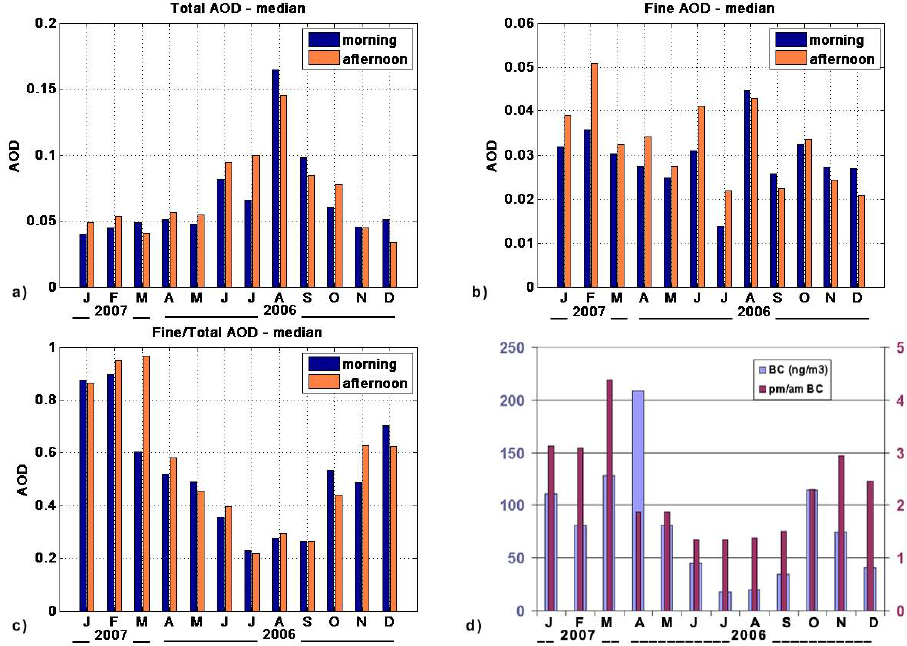
Fig. 5. Ev-K2-CNR monthly medians of morning (blue bars) and afternoon (orange bars) sunphotometer observations of: (a) total AOD, (b) fine mode AOD, (c) fine to total AOD ratio. In (d) purple bars report the median black carbon content (ng/m 3 , left axis) and the afternoon/morning black carbon ratio (red bars, right axis) measured at ground level at